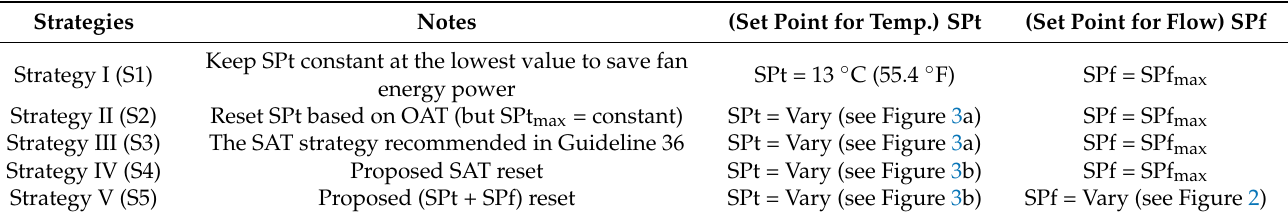
Table 1. Investigated resetting